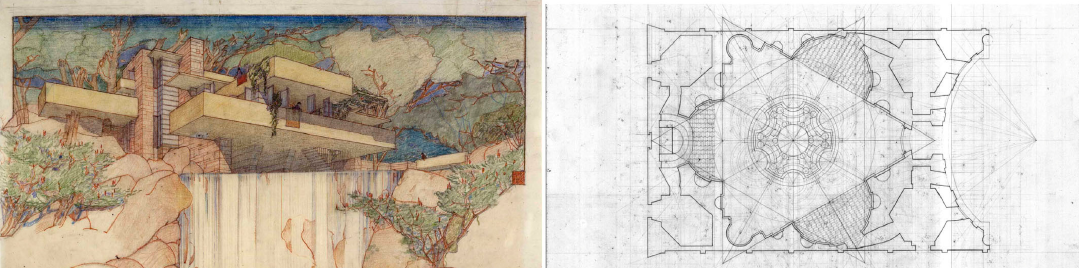
Figure 1. Images that embody the imagination of their author (project design) and images that attempt to trace back their original intentions (survey